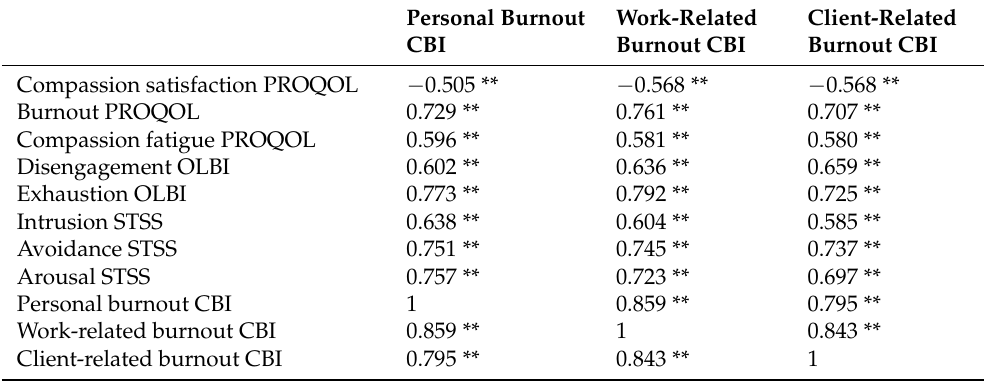
Table 4. Pearson correlations between the CBI subscales and the PROQOL, OLBI, and STSS